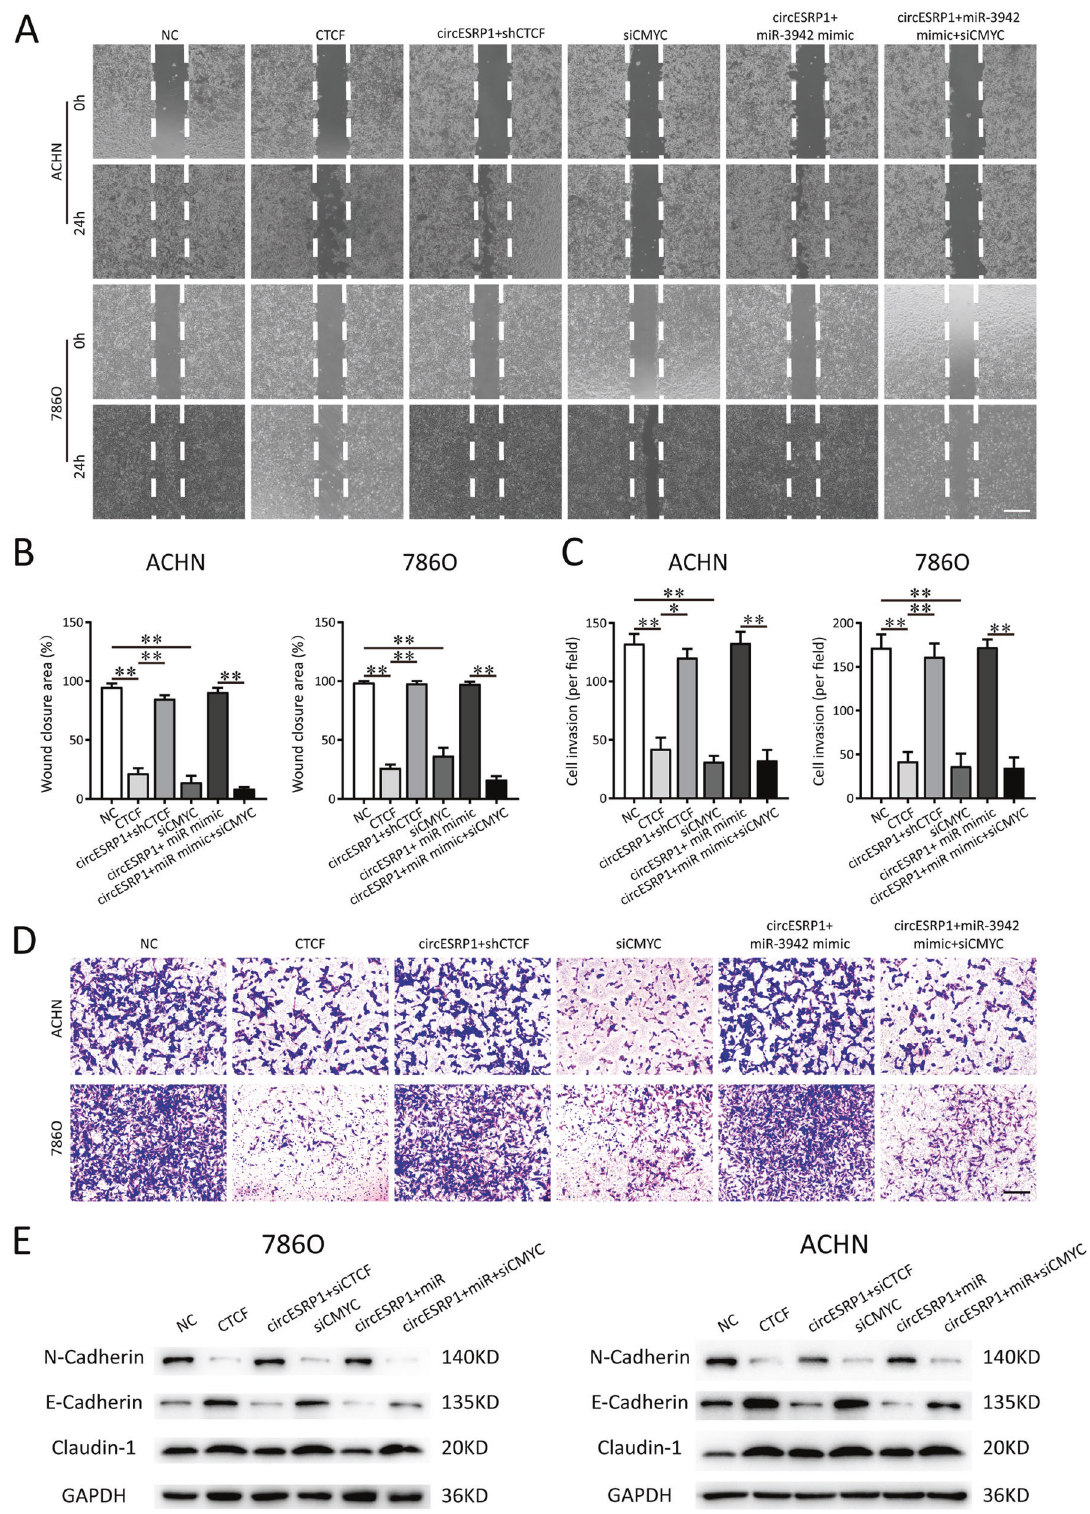
Fig. 7 circESRP1/miR-3942/CTCF positive feedback loop modulates ccRCC metastasis. A , B The migrative ability of 786O and ACHN cells was detected using wound healing assay with the transfection of CTCF overexpressed plasmid (CTCF), CTCF shRNA (shCTCF), circESRP1- overexpressing lentivirus plasmid (circESRP1), c-Myc siRNA (si-c-Myc), and miR-3942 mimic. Scale bar: 200 μ m. C , D The invasive ability of 786O and ACHN cells was detected by matrigel invasion assay. Scale bar: 50 μ m. E Western blot showed expression of different epithelial and mesenchymal markers (N-cadherin, E-cadherin, and Claudin-1). The data are presented as the mean ( n = 3) ± SEM. * p < 0.05; ** p < 0.01.